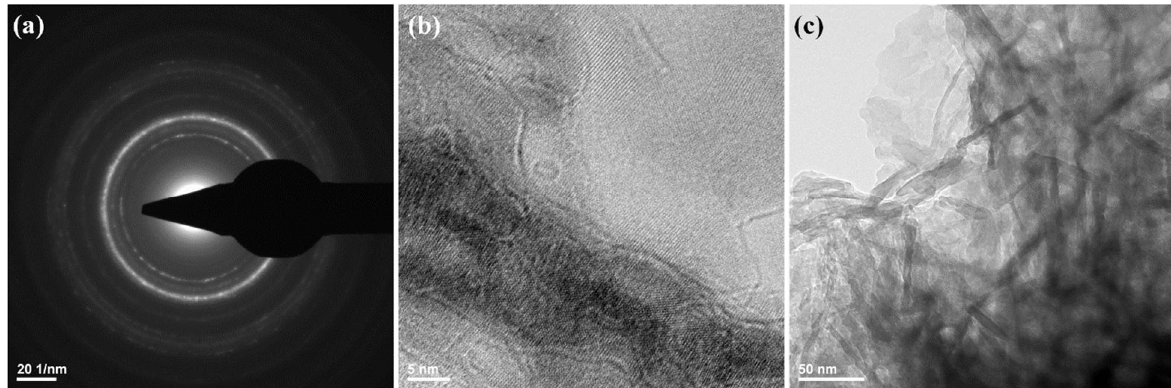
Figure 2. SAED pattern ( a ) and TEM images ( b , c ) of HAp powdery sample.